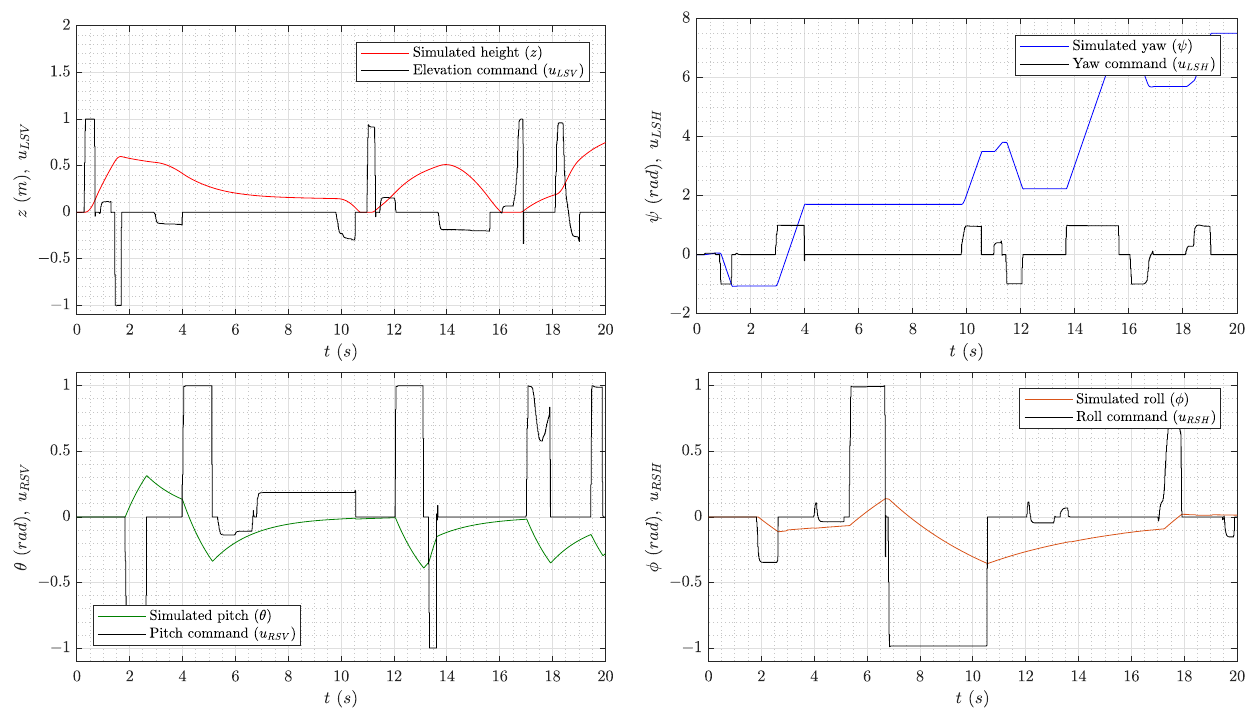
Figure 12. The data retrieved from the virtual simulator using arbitrary commands from the Xbox Series